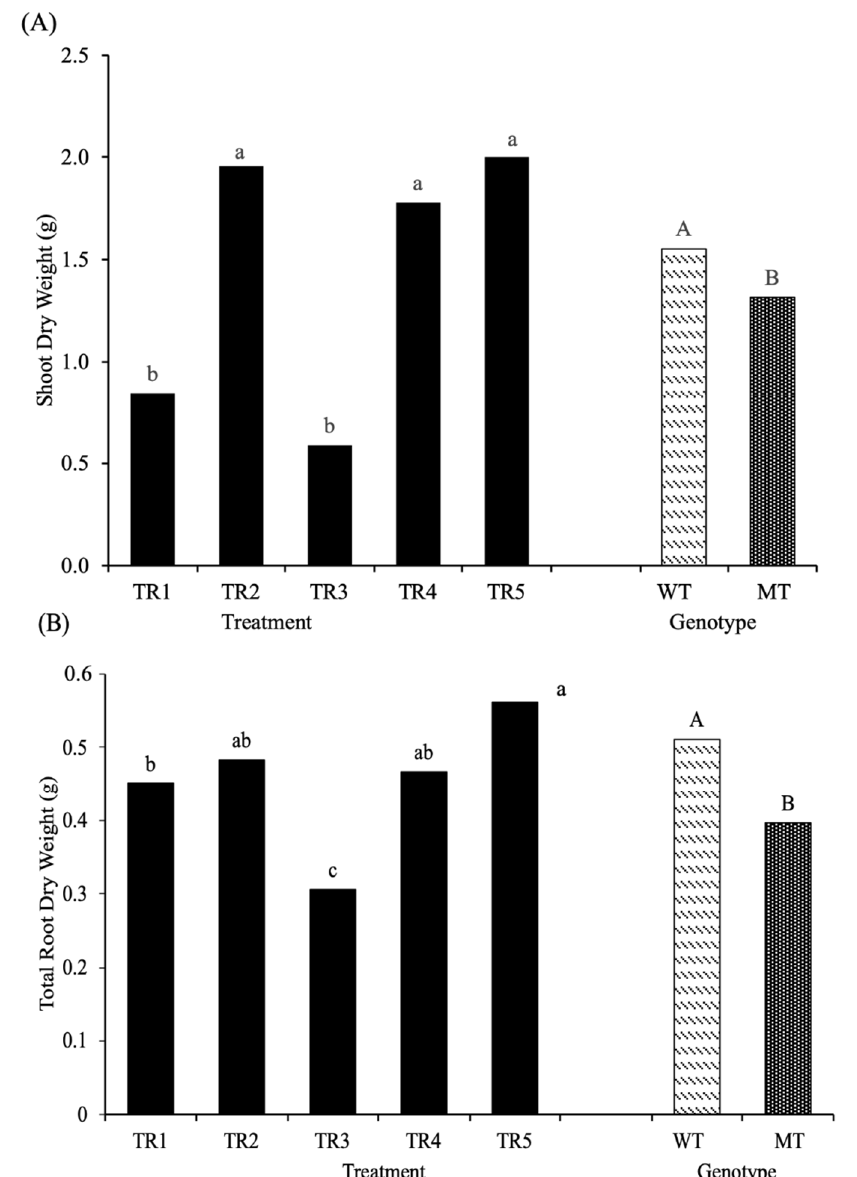
Figure 6. Shoot and total root dry biomass of two barley genotypes in a split-root system with the following P treatments: TR1-TCP/CNS-P; TR2-H 2 O/CNS; TR3-H 2 O/CNS-P; TR4-H 2 O/CNS-P + TCP; TR5-CNS/CNS, ( A ) Shoot dry weight ( B ) Root dry weight, total root dry weight which was calculated by adding left and right root dry biomass together. Different lower-case letters indicate significant differences ( p ≤ 0.05) among P treatments and different upper-case letters indicate significant difference ( p ≤ 0.05) between the genotypes according to a Tukey’s HSD test. WT represents the wild type, and MT the root hairless mutant brb .